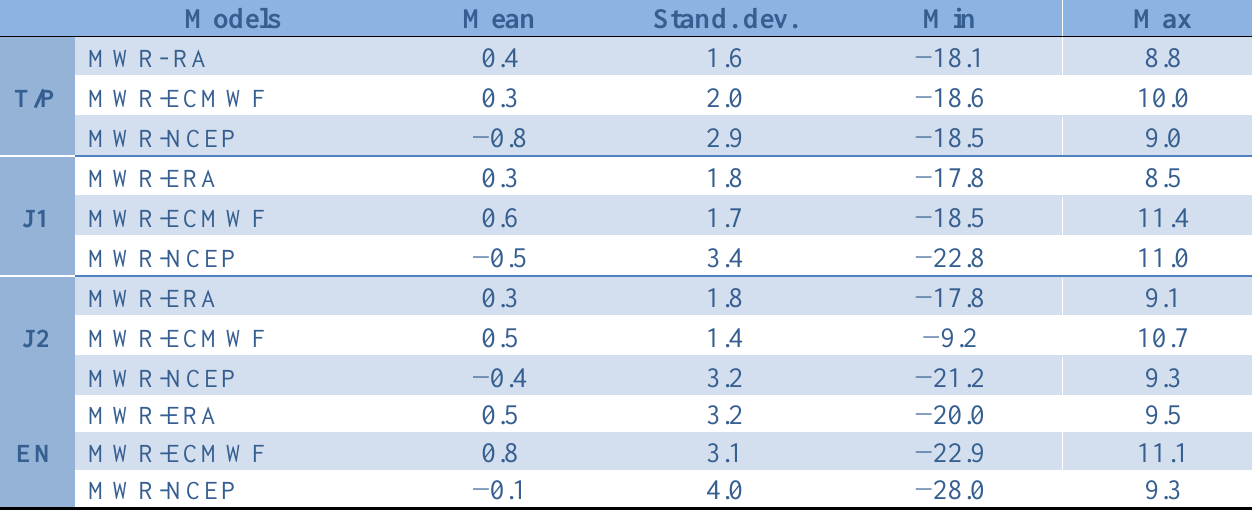
Table 3. Statistical parameters (in cm) of the comparison of the various WTC for the Caspian Sea. Values refer to the differences for the following periods of each mission: